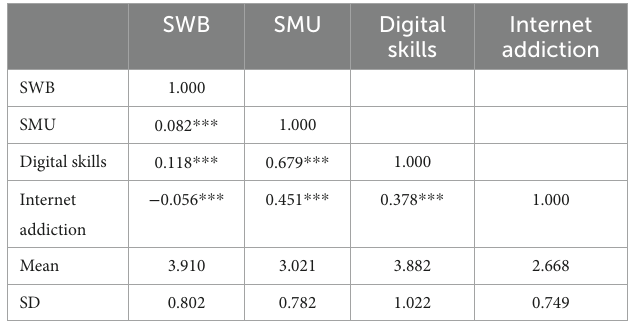
TABLE 2 Results of the correlation